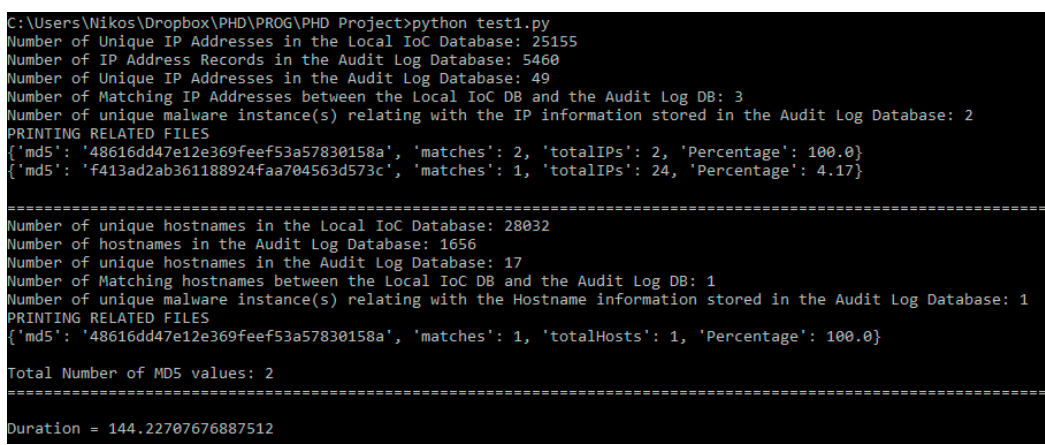
Figure 6. Sample execution of the threat intelligence module.